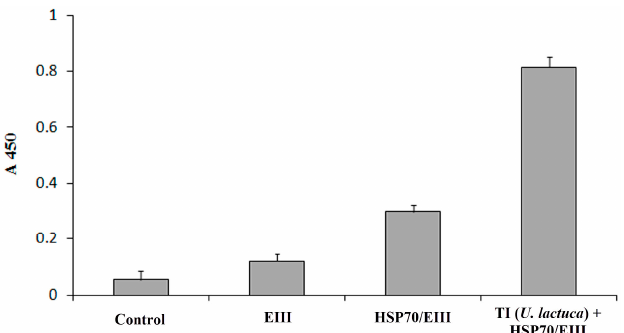
Figure 3. The levels of anti-EIII antibodies in blood sera of mice injected with EIII, chimeric HSP70/EIII protein and HSP70/EIII incorporated in tubular immunostimulating complex (TI) based on monogalactosyldiacylglycerol (MGDG) from Ulva lactuca (TI ( U. lactuca ) + HSP70/EIII). Control—mice injected with PBS. Bars represent mean ± S.D. values. Y axis represents absorbance at 450 nm (A450). TI-complex comprised CDA, cholesterol and MGDG at weight ratio of 2:2:4. The use of the Y. pseudotuberculosis HSP70 as an EIII companion protein likely leads to better